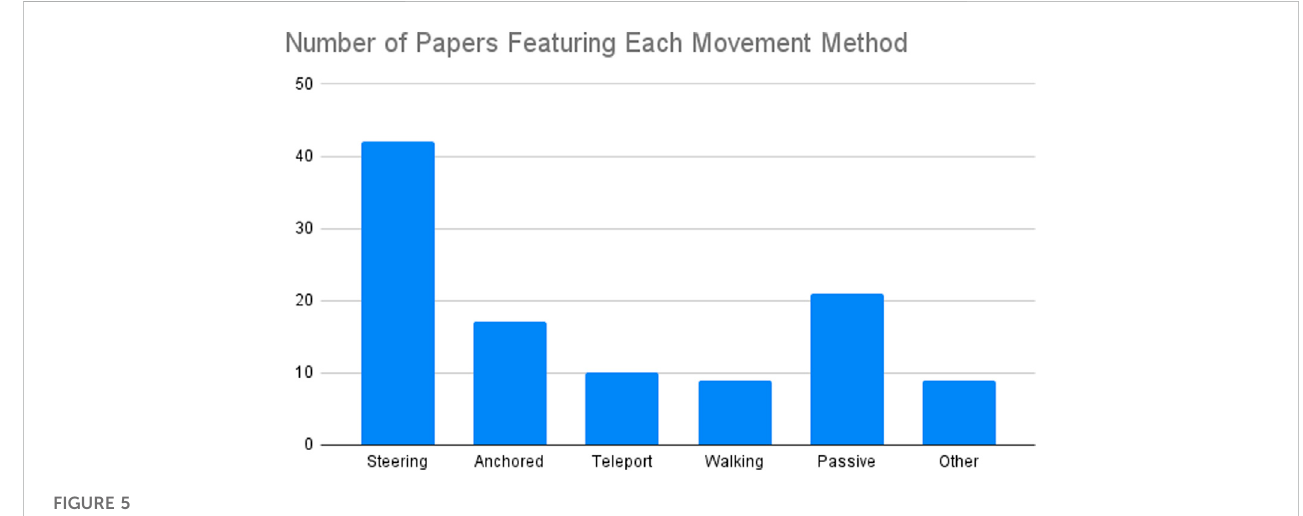
FIGURE 5 The number of papers featuring each movement